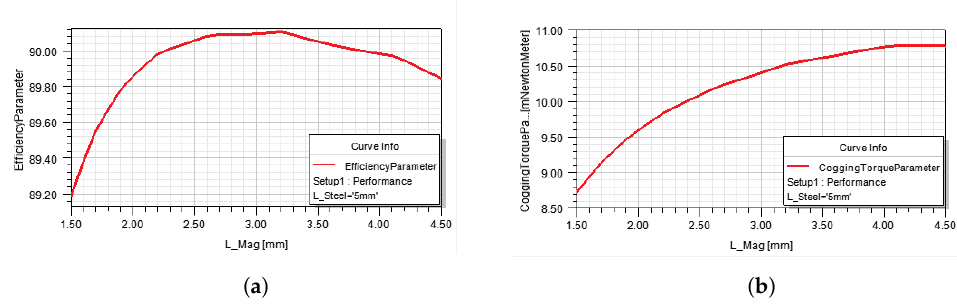
Figure 7. Effect of magnet thickness on ( a ) efficiency ( b ) cogging torque.